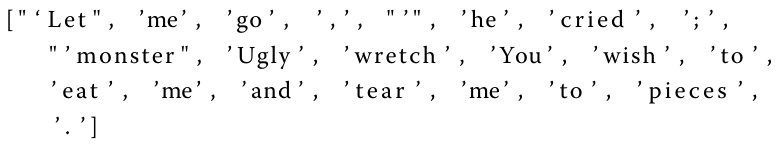
a text sample is first split into tokens and the lengths of the tokens are calculated. The positions of the tokens gained from the texts are used as the ordering index (time-axis) while the lengths of the tokens are used as the values of the language time